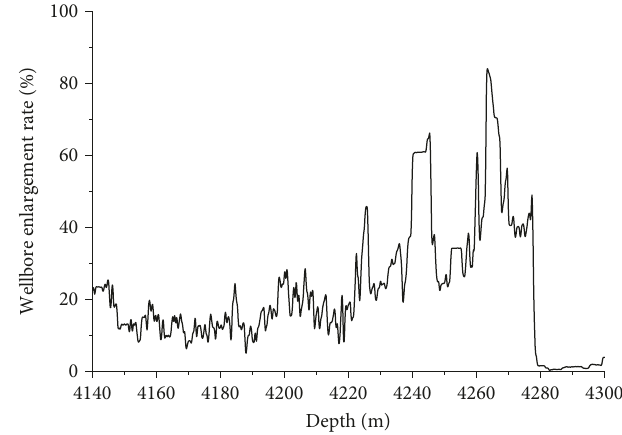
Figure 21: Field results of the enlargement rate of the W-82 well.